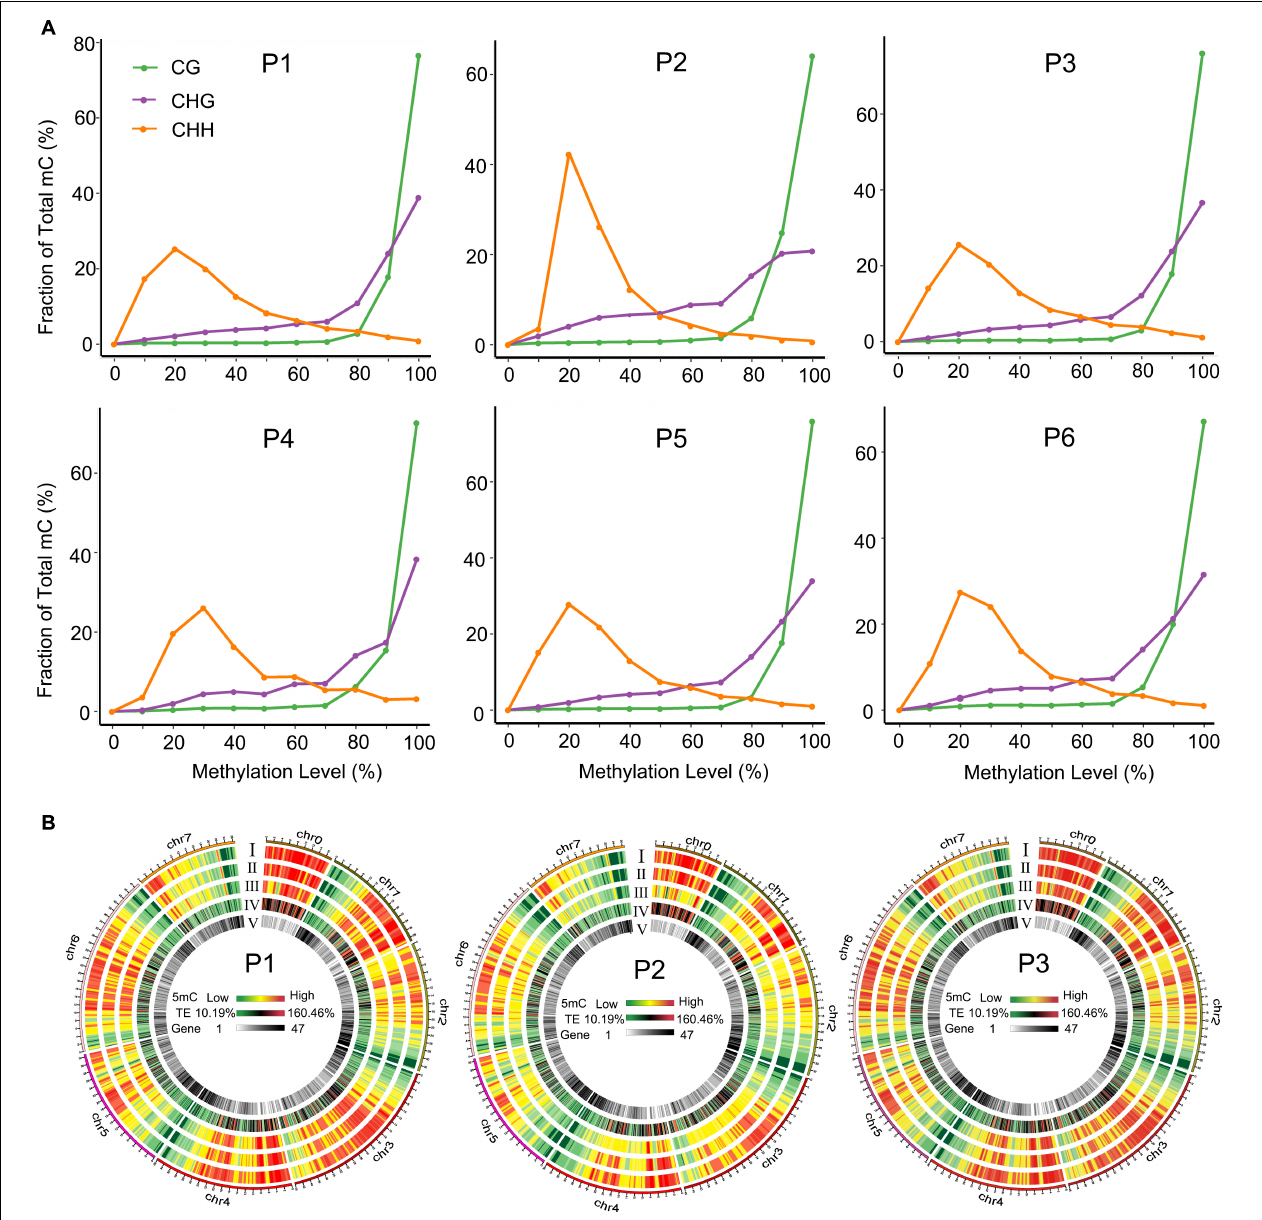
FIGURE 2 | Distribution of methylation levels in different tissue culture stages. (A) Distribution of methylation levels in different sequence contexts. (B) Circos heat maps of methylation level and gene density distribution along chromosomes of F. nilgerrensis in P1 (shoot tips), P2 (callus induction), and P3 (shoot induction). Heatmaps I to V represented the methylation density in the CG, CHG, CHH contexts, TE density, and gene density,